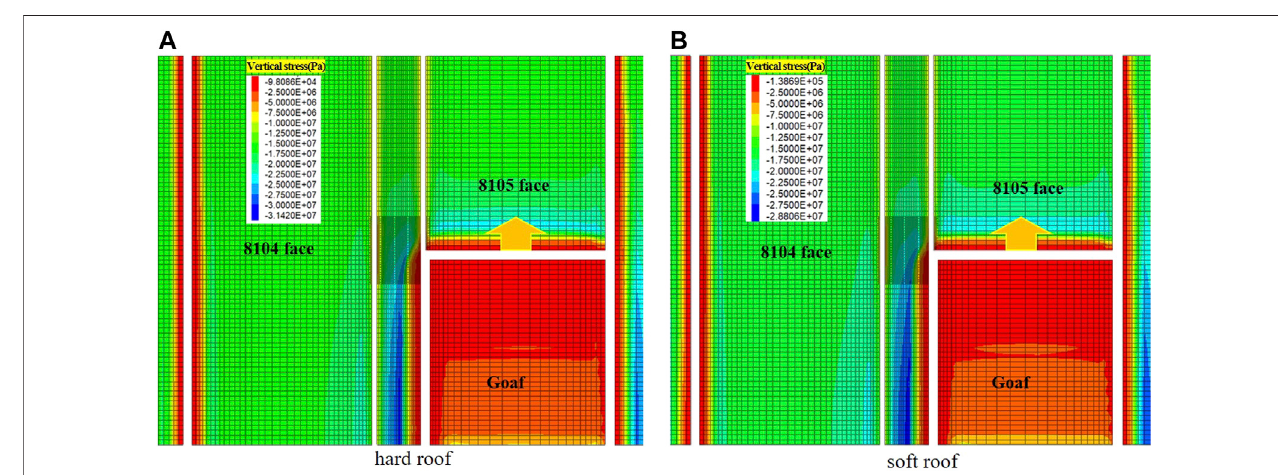
FIGURE 5 | Vertical stress distribution after primary mining under different roof strength